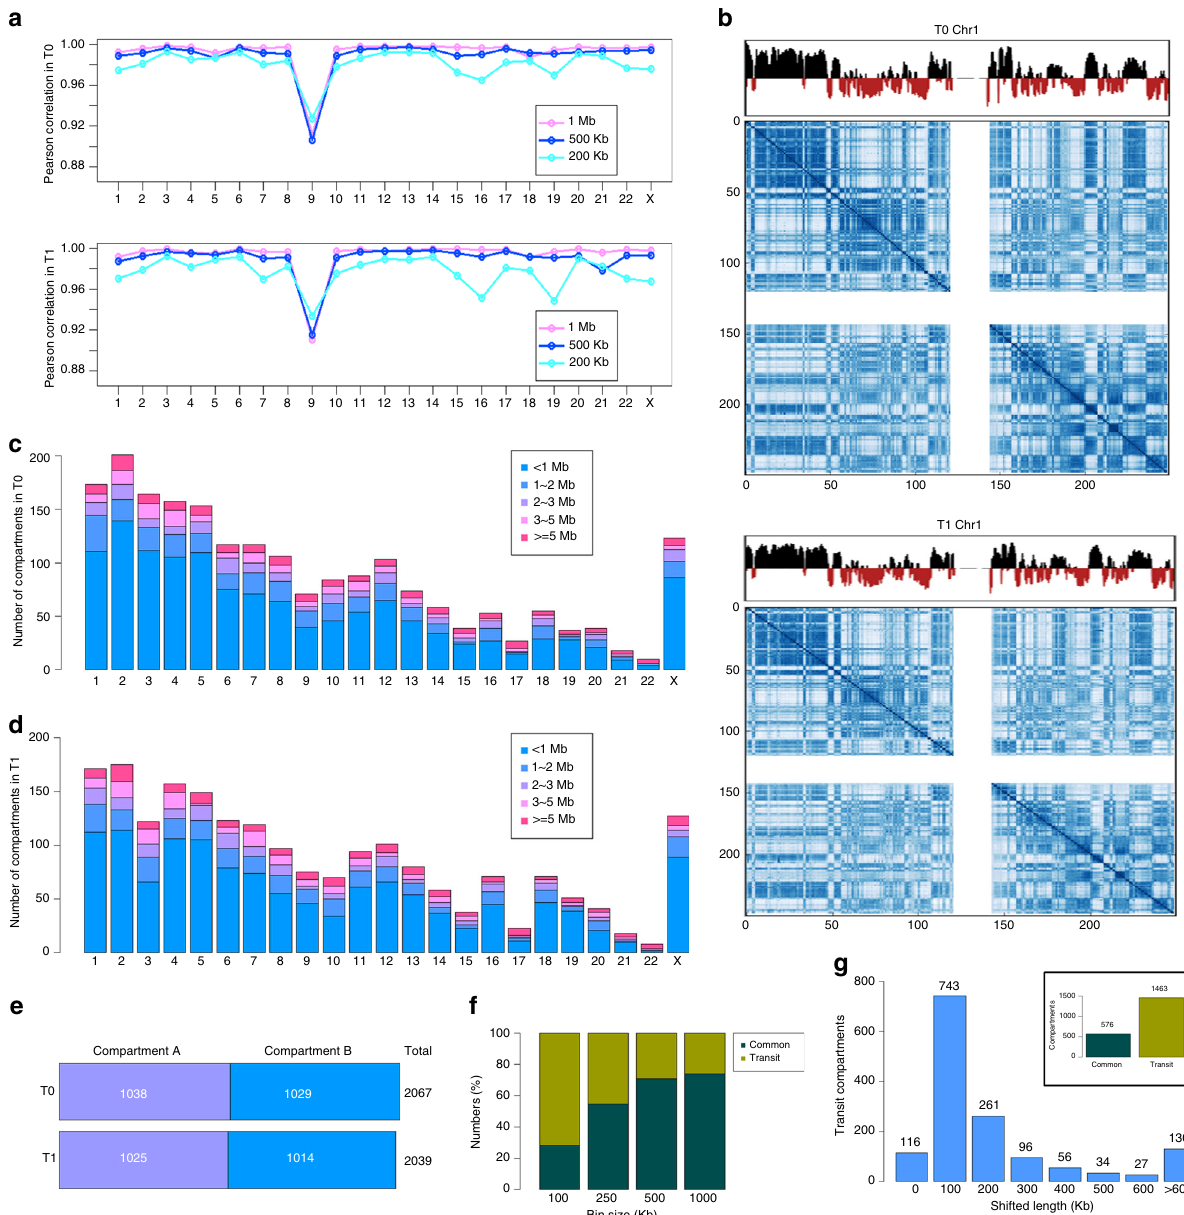
Fig. 1 Identi fi cation of E2-induced compartments in MCF7 cells at T1 vs. T0. a Pearson correlation of two biological replicates with the bin size of 1 Mb, 500 Kb and 200 Kb on individual chromosomes at untreated MCF7 cells (T0) (Top) and E2-treated MCF7 cells for 1 h (T1) (Bottom). b Contacts matrices of compartment A (Black) and B (Red) at T0 (Top) and T1 (Bottom) respectively. c , d Histograms of compartments with different sizes at T0 and T1 respectively. e Distribution of compartments A and B in T0 and T1 respectively. f The percentage of common and transit compartments at T1 vs. T0 with various bin sizes. g The number of compartments of T1 vs. T0 with various shifted length when bin size is 100 Supplementary Figs. 6 – 11). We used the Common and Transit compartments obtained from the comparison of T1 vs. T0 and compared them to T4, T16 and T24 respectively. We also sepa- rated the comparison of active open chromatin compartment A (Fig. 2a — upper panel) from inactive close chromatin compart- ment B (Fig. 2a — lower panel). When re-examining these sets of Common or Transit compartments, we identi fi ed 15 patterns of changed compartments from 16 sets (Supplementary Fig. 14) and 9 additional patterns from the last set (labeled X in Supplemen- tary Fig. 14) based on the converted bins (see the de fi nition in Supplementary Fig. 15). Unexpectedly, we were able to categorize these 24 patterns of chromatin into six types of temporally